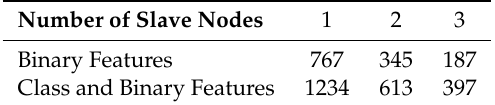
Table 9. Running time per slave nodes (in seconds) for Spark